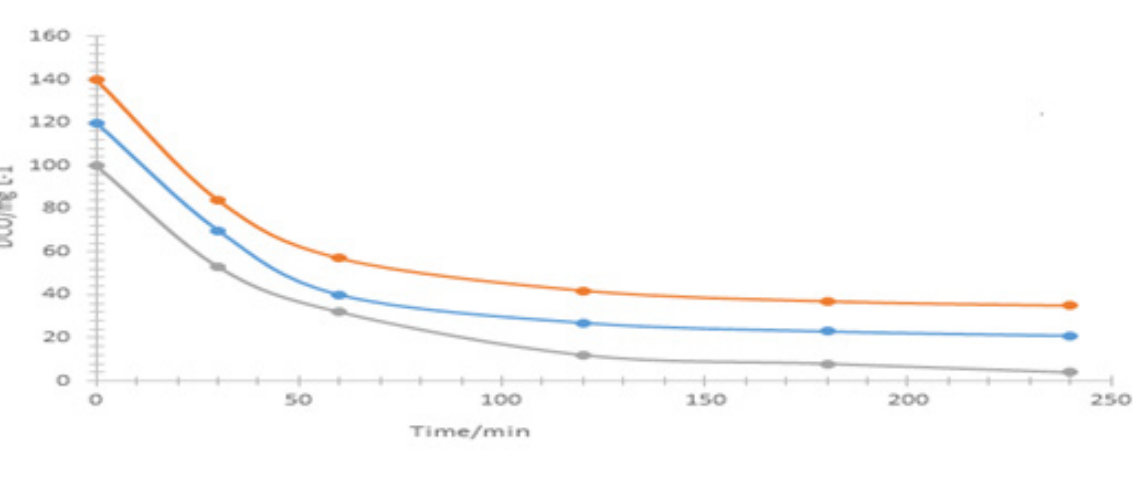
Figure 4: Influence of the different gentamicin concentrations, for 0.1 ( ), 0.12 ( ) and 0.14 mM ( ), solutions during electro-Fenton under the conditions: [Fe 3+ ] = 0.1 mM [Na